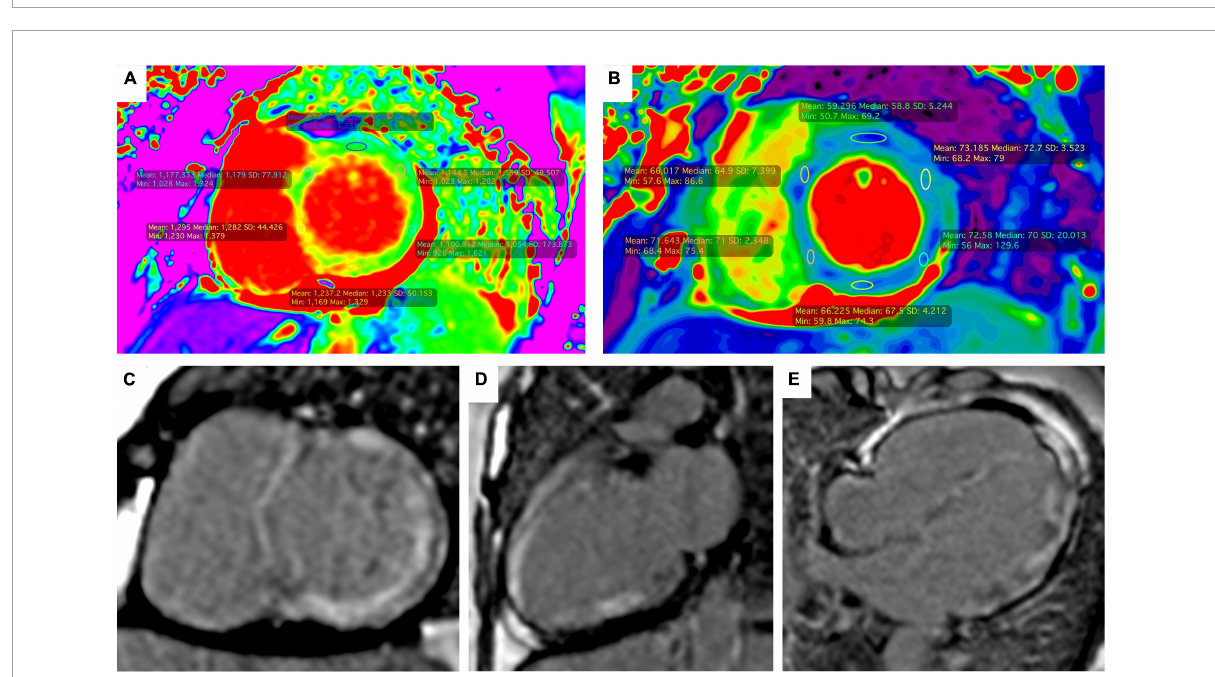
FIGURE3 Magnetic resonance imaging. Short-axis ShMOLLI color maps showing diffuse high native values T1 (A) and T2 (B) which is compatible with myocardial edema and fibrosis. Late gadolinium enhancement with intramyocardial and transmural pattern was observed in the short axis view (C) , two chambers view (D) and four chambers view (E)